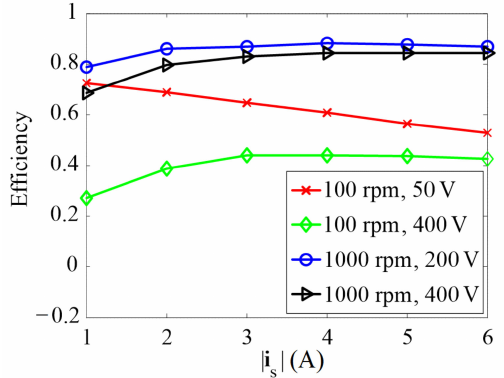
Figure 3. Measured e ffi ciency characteristics of the PMSM drive at di ff erent rotor speed and di ff erent DC-bus